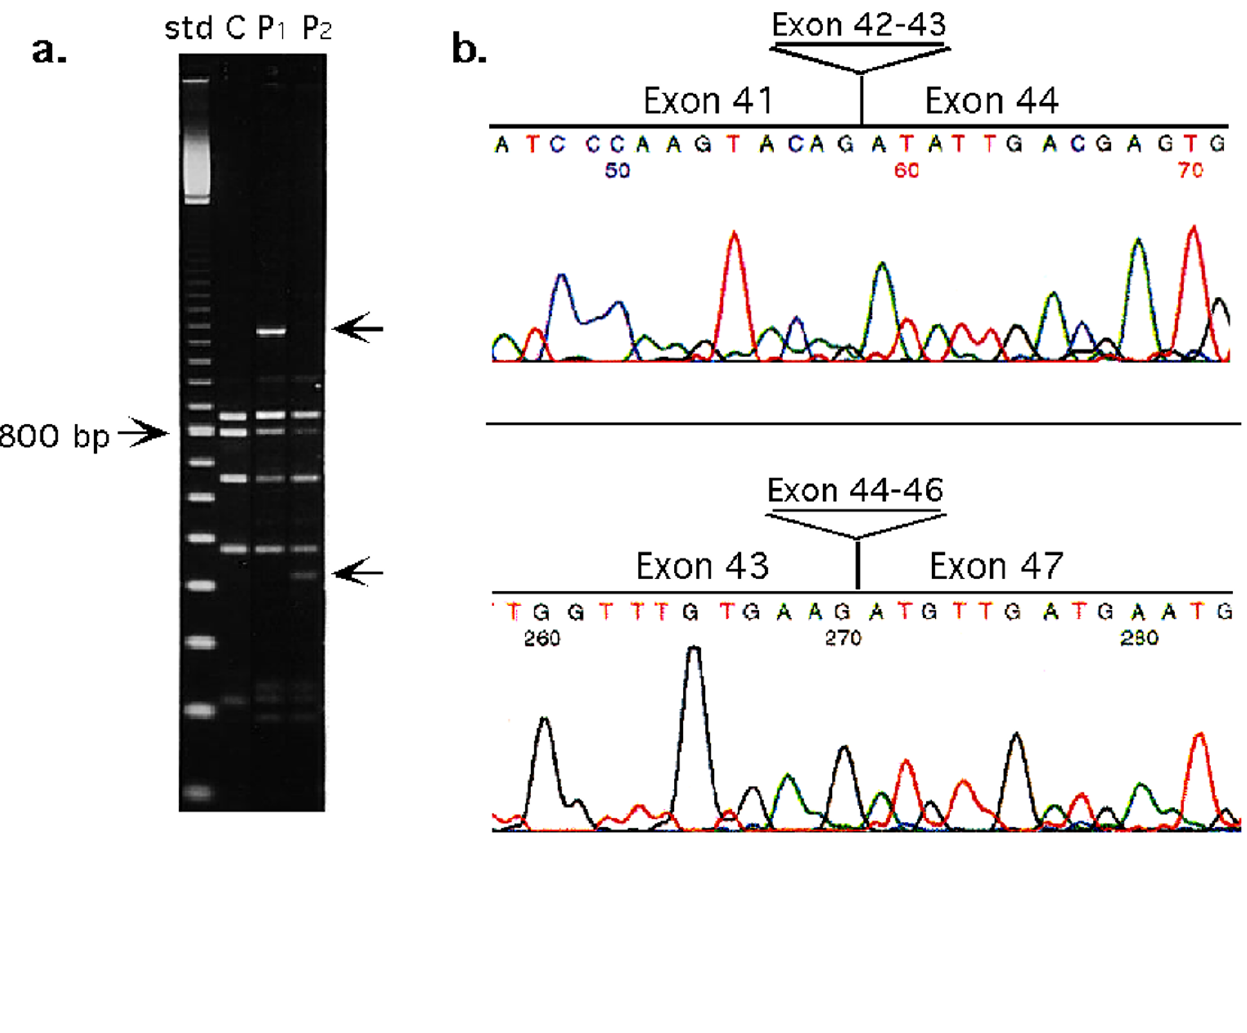
Figure 1 (a) Comparison of the Taq I restriction fragment patterns of long RT-PCR products containing FBN1 exons 29–52. Sample C is amplified from a normal control, PI represents patient 1 (FB774) and P2 patient 2 (and FB890). Lane 1 is a 100 bp ladder. Arrows point to the abnormal fragments in the patient lanes. (b) Direct sequencing analysis of the DNA isolated from the altered restriction fragments reveals deletion of exons 42–43 in patient 1 (top) and of exons 44–46 in patient 2